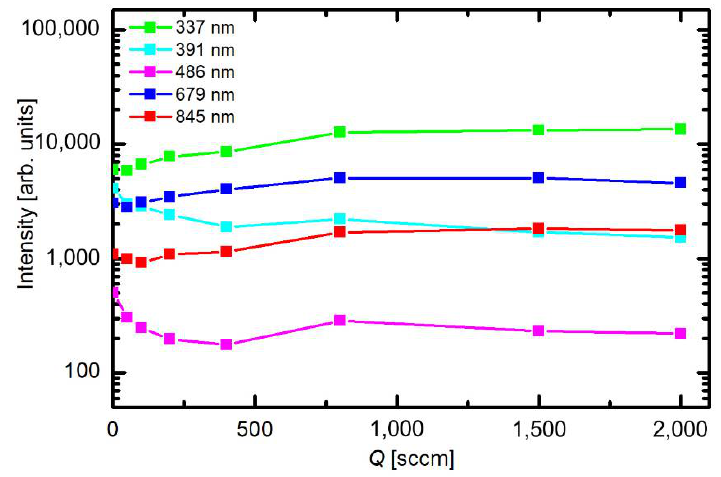
Figure 4. Intensity of selected spectral features versus air flow rate at the pressure of 80 Pa.